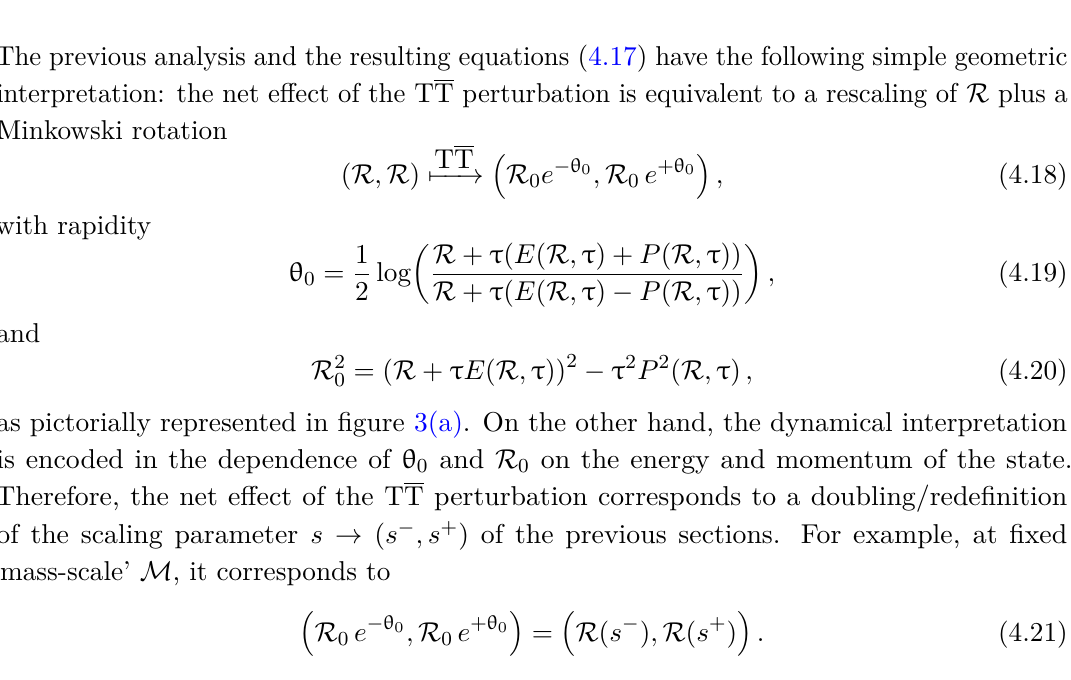
Figure 3. Pictorial representation of the net effect of the TT perturbation, as a rescaling of the ‘volume’ plus a Minkowski rotation. Figure 3(a) corresponds to equation (4.18), while figure 3(b) to the inverse relation